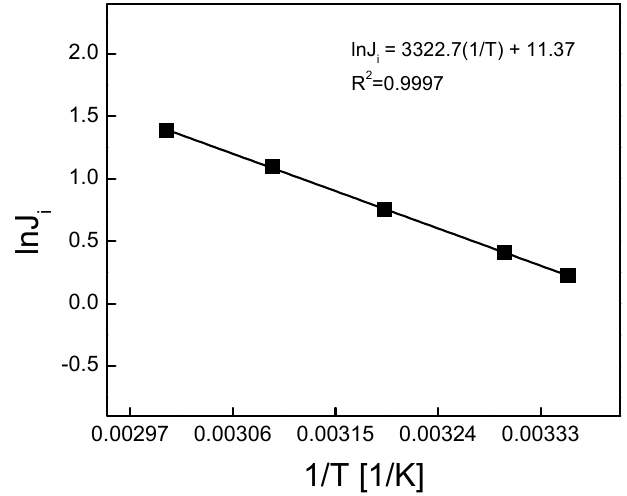
Figure 7. Arrhenius plot of Ag(I) transport across the PIM with calixpyrrole (KP). Source phase: 1.0 × 10 − 3 M AgNO 3 , pH = 4.0; membrane: 4.0 cm 3 o -NPPE/1.0 g CTA; 0.050 M KP, receiving phase: 0.10 M Na 2 S 2 O 3 .